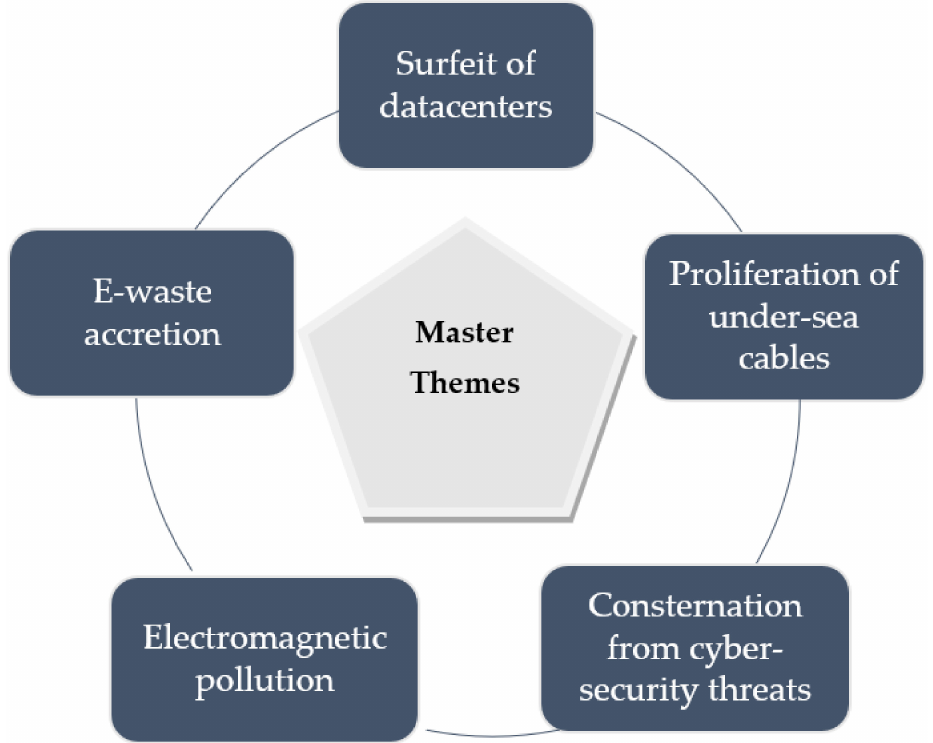
Figure 1. Five master themes generated from meta-integration